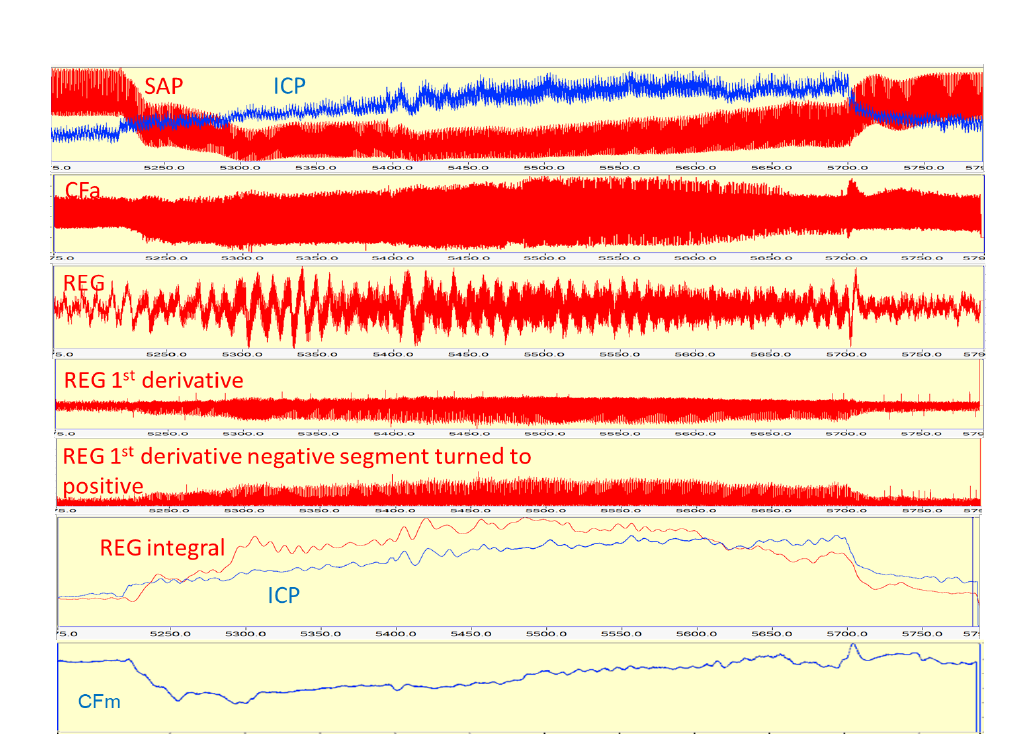
Figure 11. Continuous analog parameters (as a strip chart) vs. time. CBF AR is